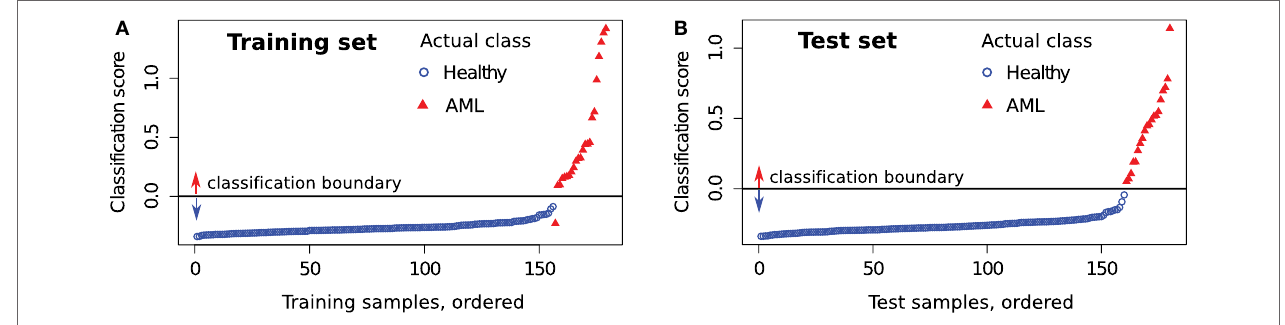
FigUre 14 | average classification score from Tubes 4 to 6 for each sample in the (a) training set and (B) test set . Samples with scores above the horizontal line are classified as AML and as healthy otherwise. The actual class of each sample is also shown. An AML sample (subject id 116) is always misclassified in the training set, and this is discussed in the